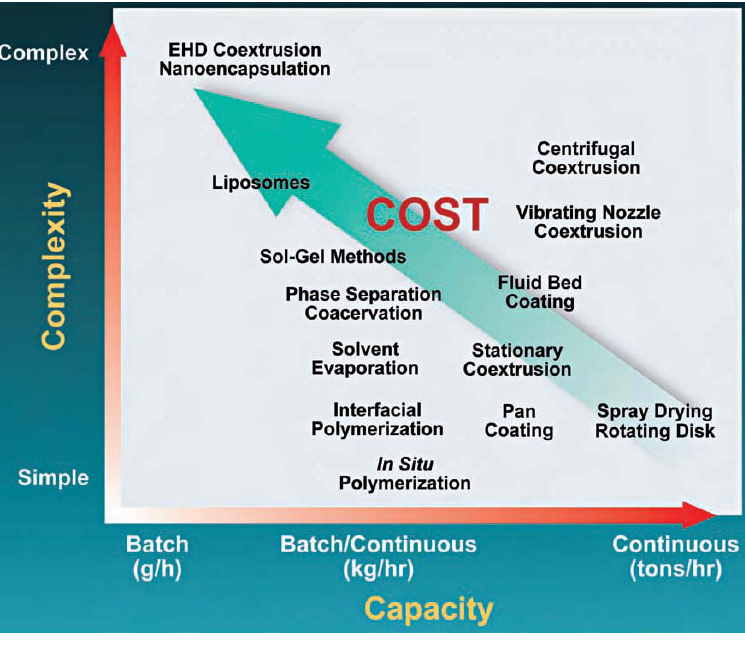
Figure 3. Encapsulation processes offer different levels of complexity, capacity. The operating cost rent of different fabrication methods is shown in coordinates of capacity (in grams to tons per hour) and complexity (from simple to complex). Reproduced with kind permission of the Southwest Research Institute from